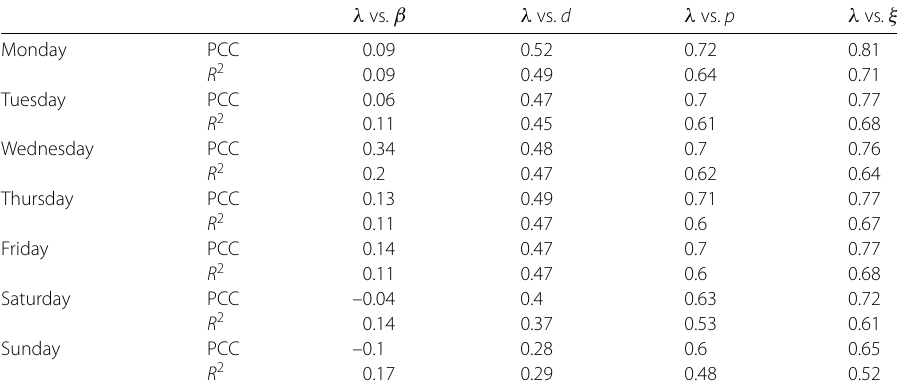
Table 1 Average PCC values and R 2 values between measured indexes across studied SDNs λ vs. β λ vs. d λ vs. p λ vs.